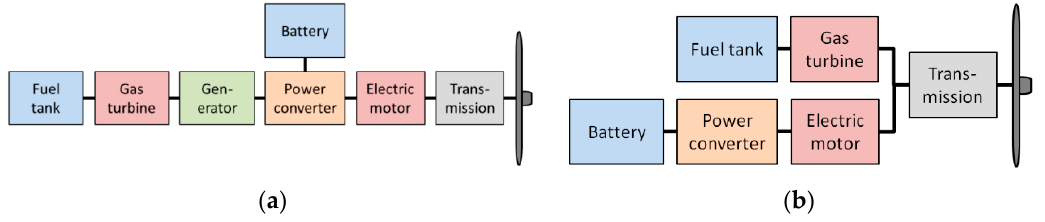
Figure 2. Schematic of a hybrid-electric propulsion system: ( a ) series configuration, ( b ) parallel configuration [27].